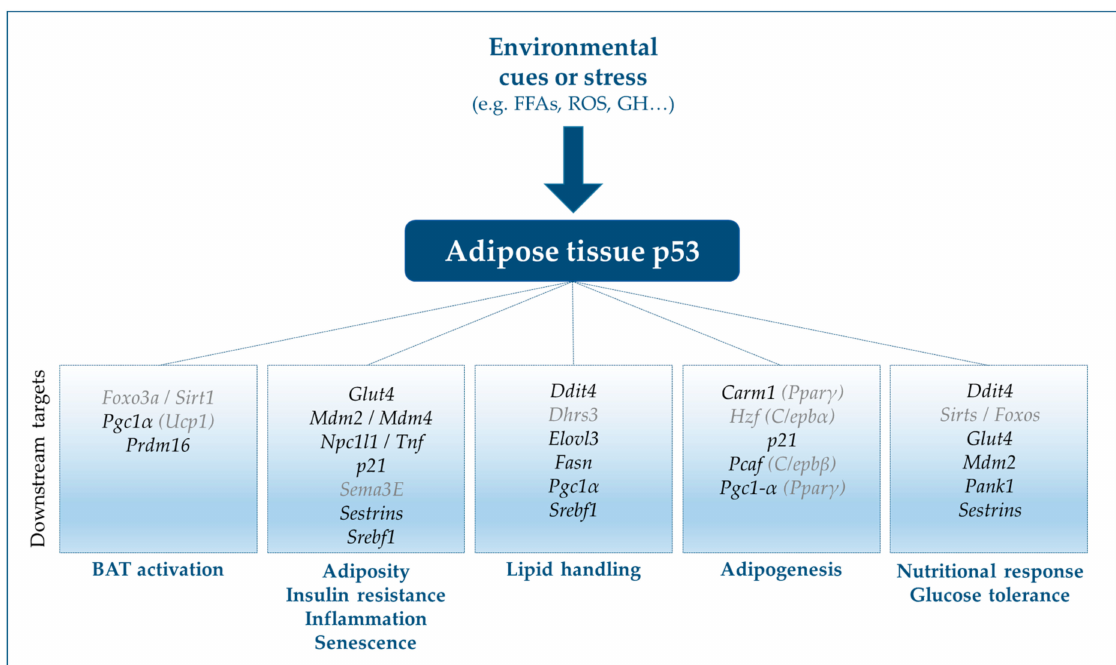
Figure 1. Actions of p53 through its target genes in adipose tissue. p53 levels in adipose tissue are determined by environmental cues and stress signals. By regulating expression of—or directly interacting with—its downstream targets, p53 coordinates several processes that are key in adipocyte development and maintenance and function of brown and white adipose tissue. Targets with a proven interaction between p53 and their promoters are in black letters, protein–protein interactions or p53-induced genes without evidence of direct regulation are in grey. In parentheses are key factors that are regulated by the corresponding p53 downstream